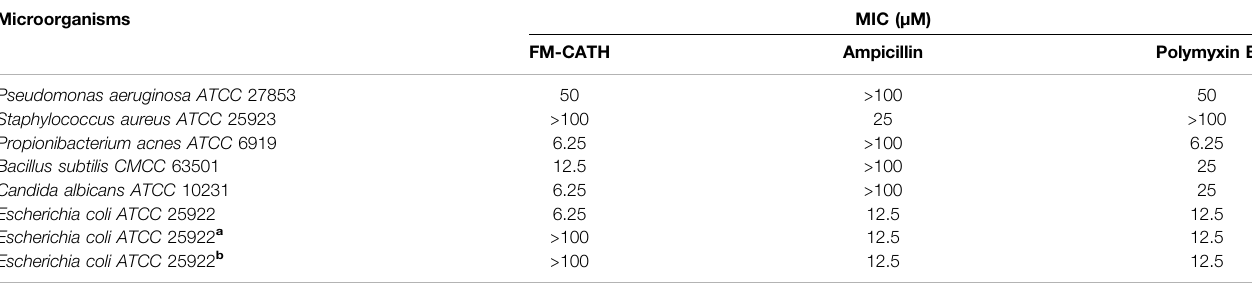
TABLE 2 | Antimicrobial activity of FM-CATH. Microorganisms